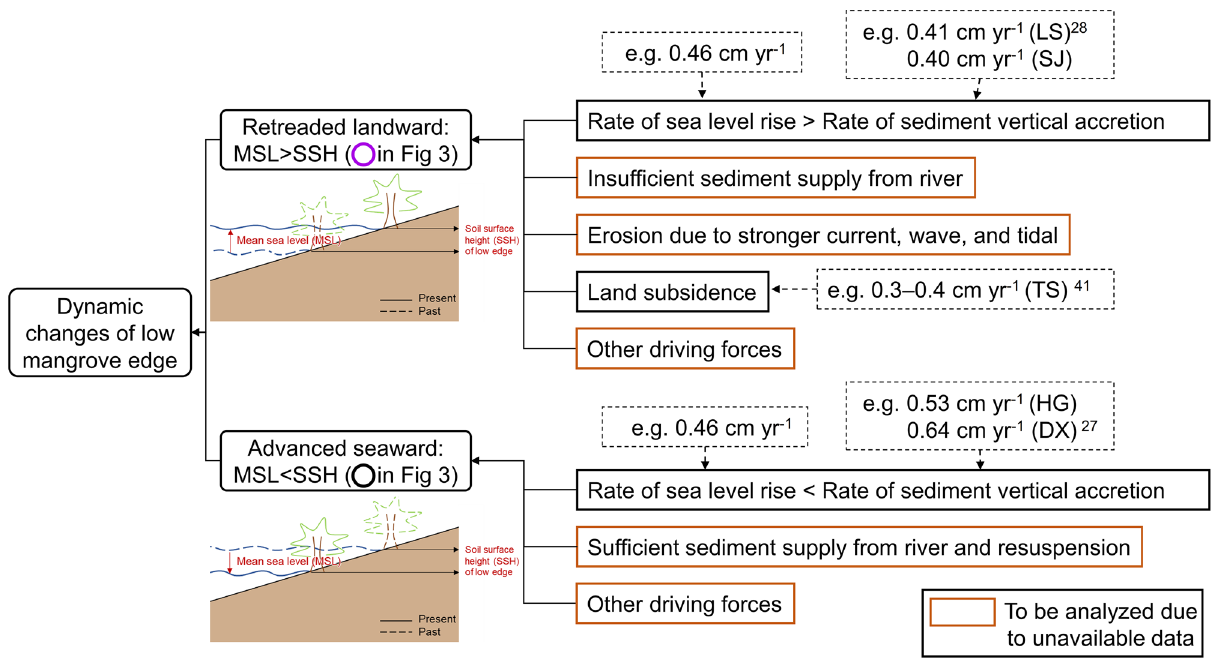
Figure 7. Conceptual framework diagram for the impact mechanism of SLR and other non-human forces on the mangrove wetland migrated seaward or landward. Figure created by R.C., R.D., and C.W.